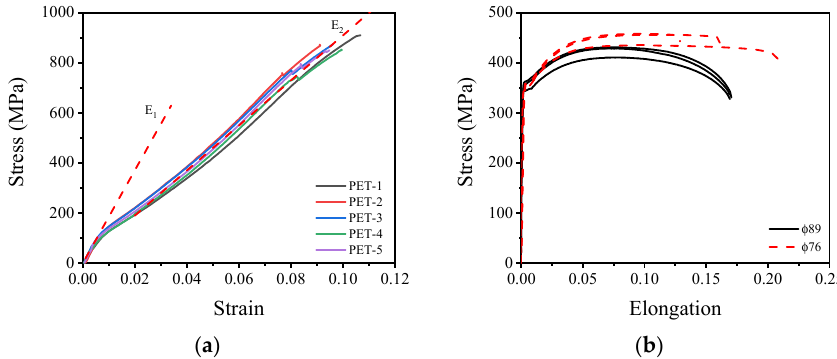
Figure 3. Tensile stress-strain curve of materials: ( a ) PET sheet; ( b ) steel tubes. Table 3. Material properties of reinforcement.